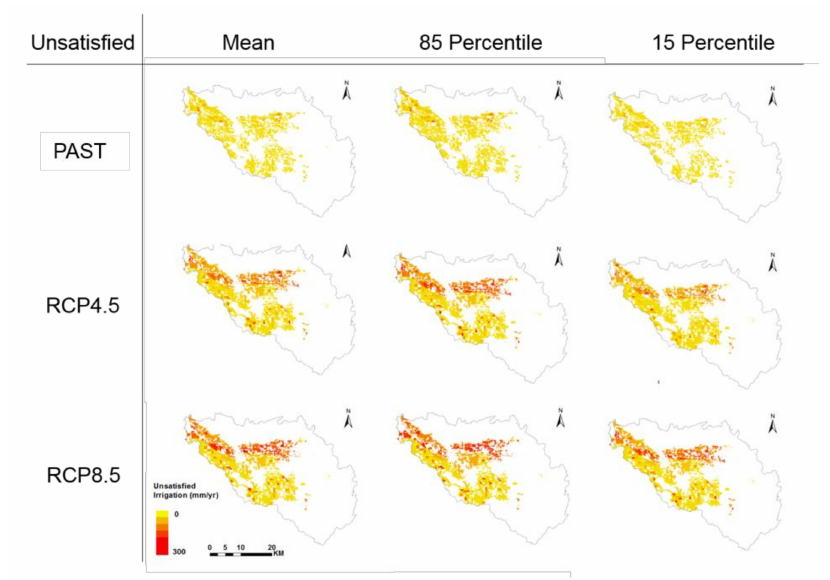
Figure 9. The annual amount of unsatisfied irrigation water under 3 different scenario groups (spatial maps show the mean, 85th, and 15 percent range for each scenario